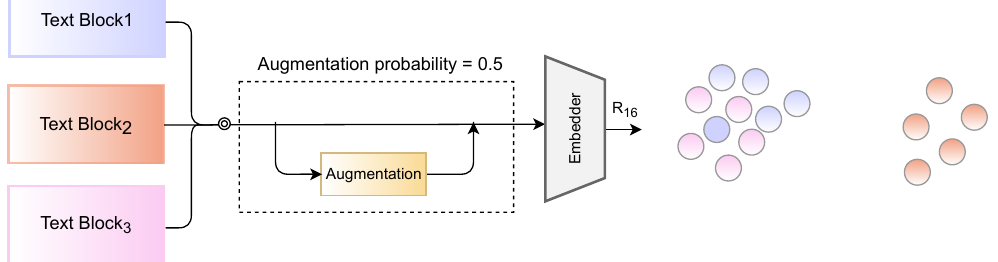
Figure 5. The same data processing pipeline is used to train both pairwise and triplet frameworks. The DL frameworks receive half of the inputs randomly augmented with an augmentation probability of